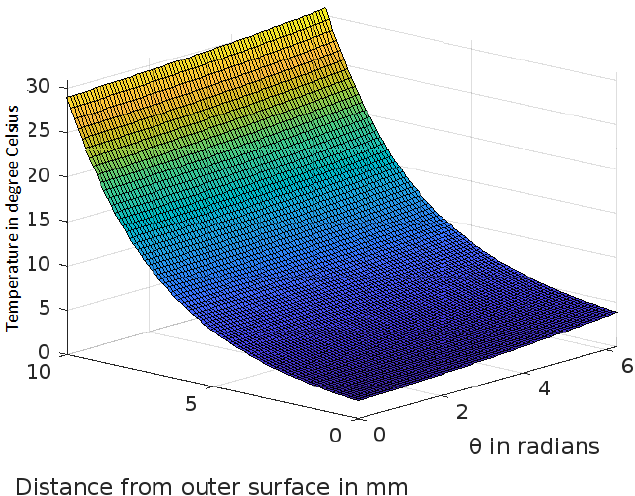
Figure 4. Variation of temperature profiles in human skin with an external temperature at the skin surface of 10 ◦ C.